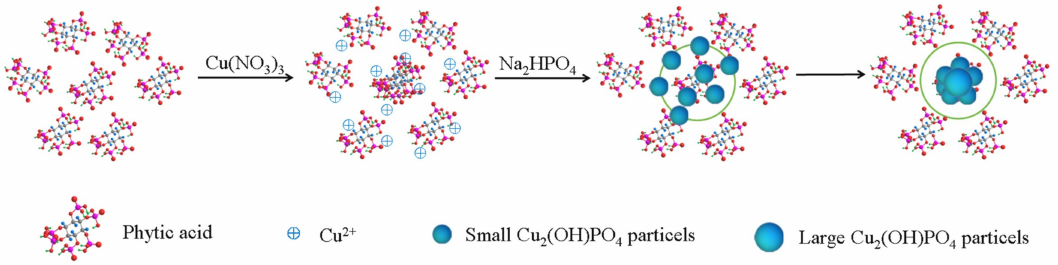
Figure 1. Schematic representation of the process for the synthesis of Cu 2 (OH)PO 4